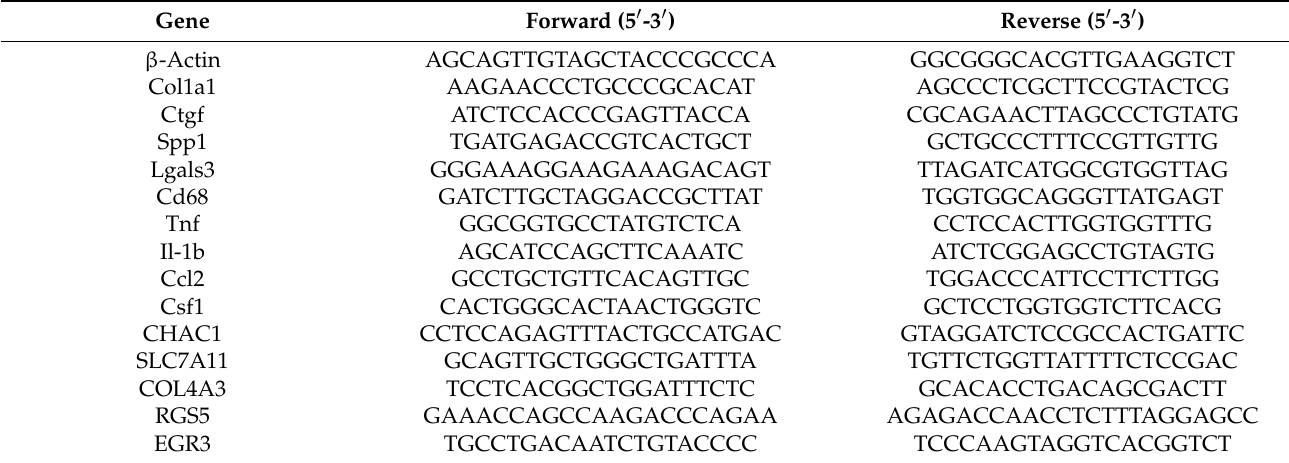
Table 1. Primer sequences for qPCR